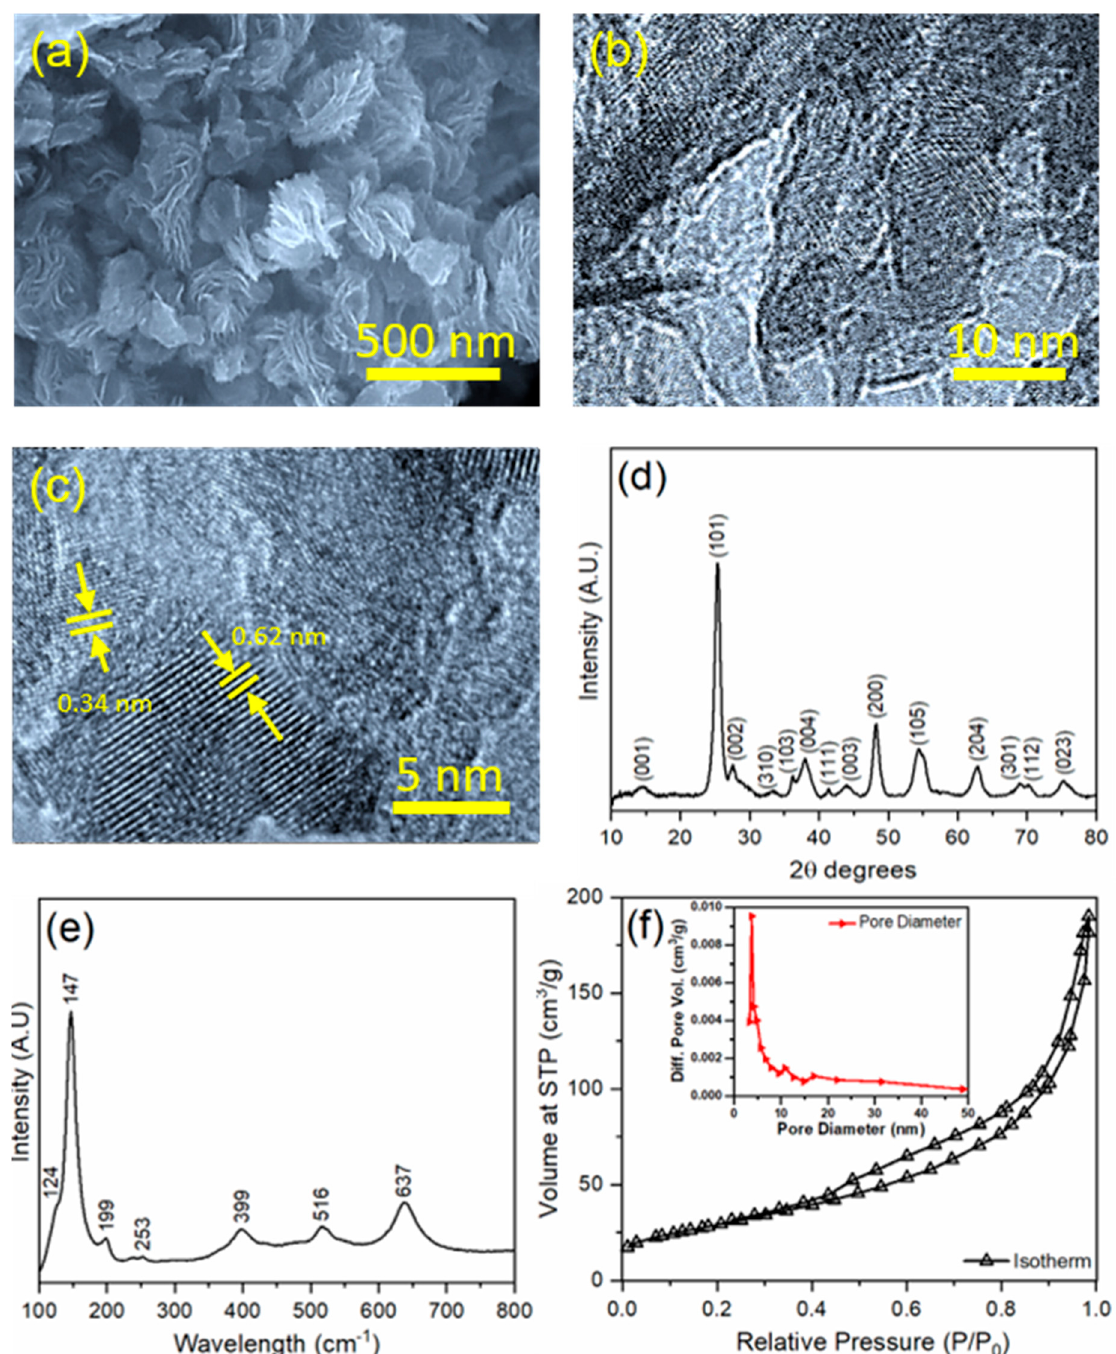
Figure 2. ( a ) SEM image, ( b , c ) TEM images, ( d ) X-ray diffraction pattern, ( e ) Raman spectrum, ( f ) N 2 adsorption–desorption isotherm, and pore size distribution (inset) of TiO 2 nanosheets.